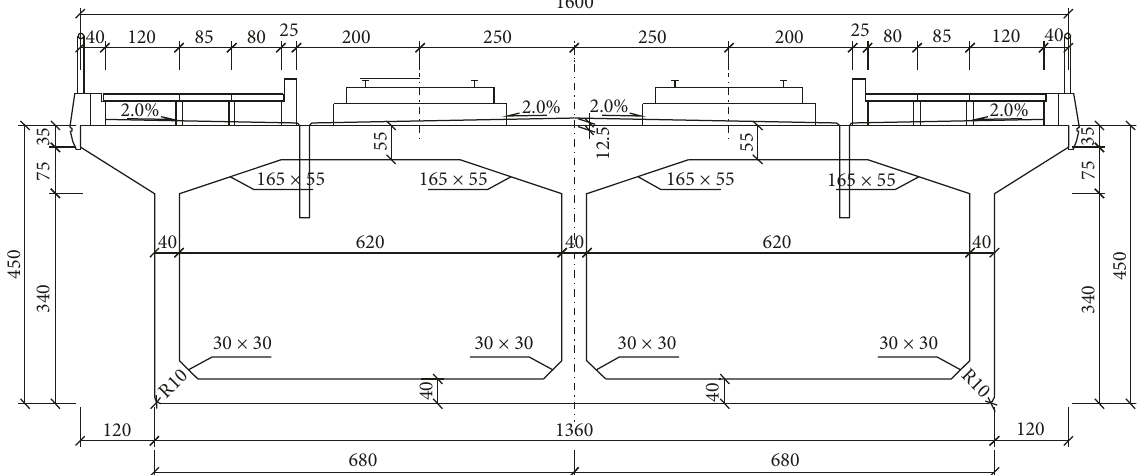
Figure 14: Cross-section of the Chengjiang bridge (unit: cm).